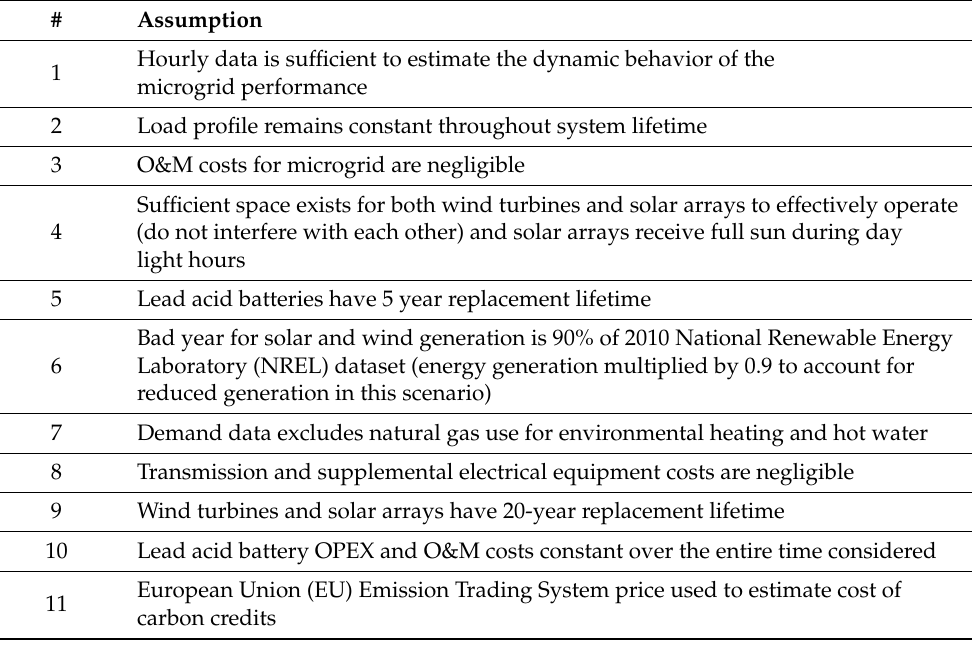
Table 4. Assumptions used in microgrid design analysis.